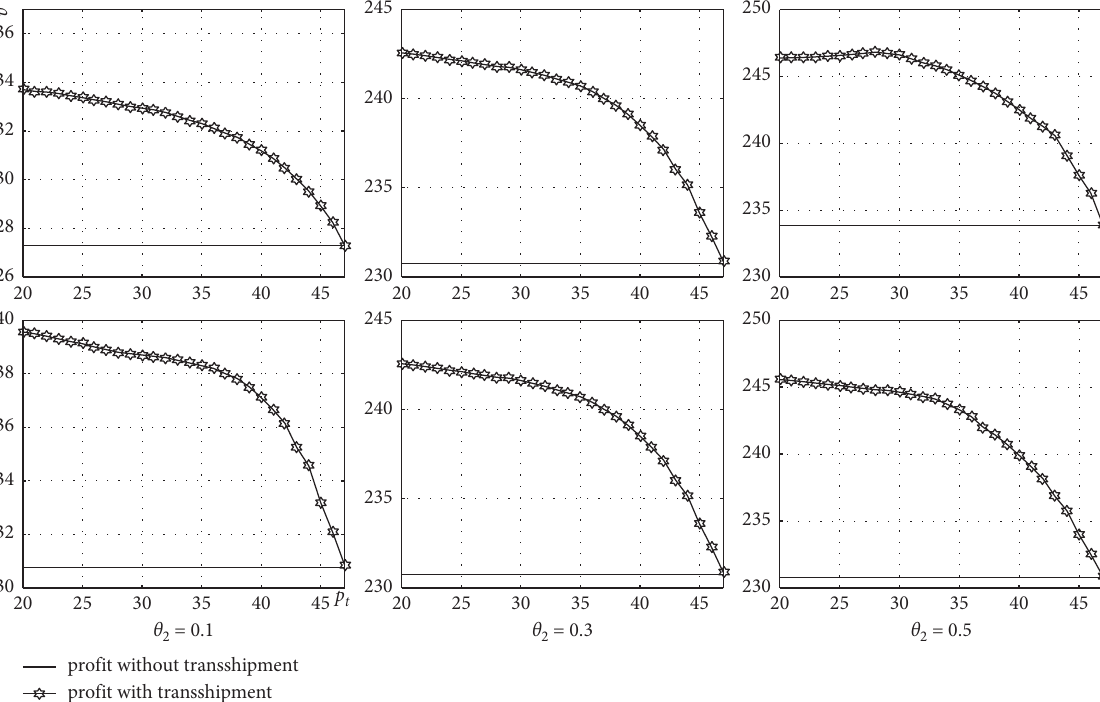
Figure 3: Relationship between the profit and switching